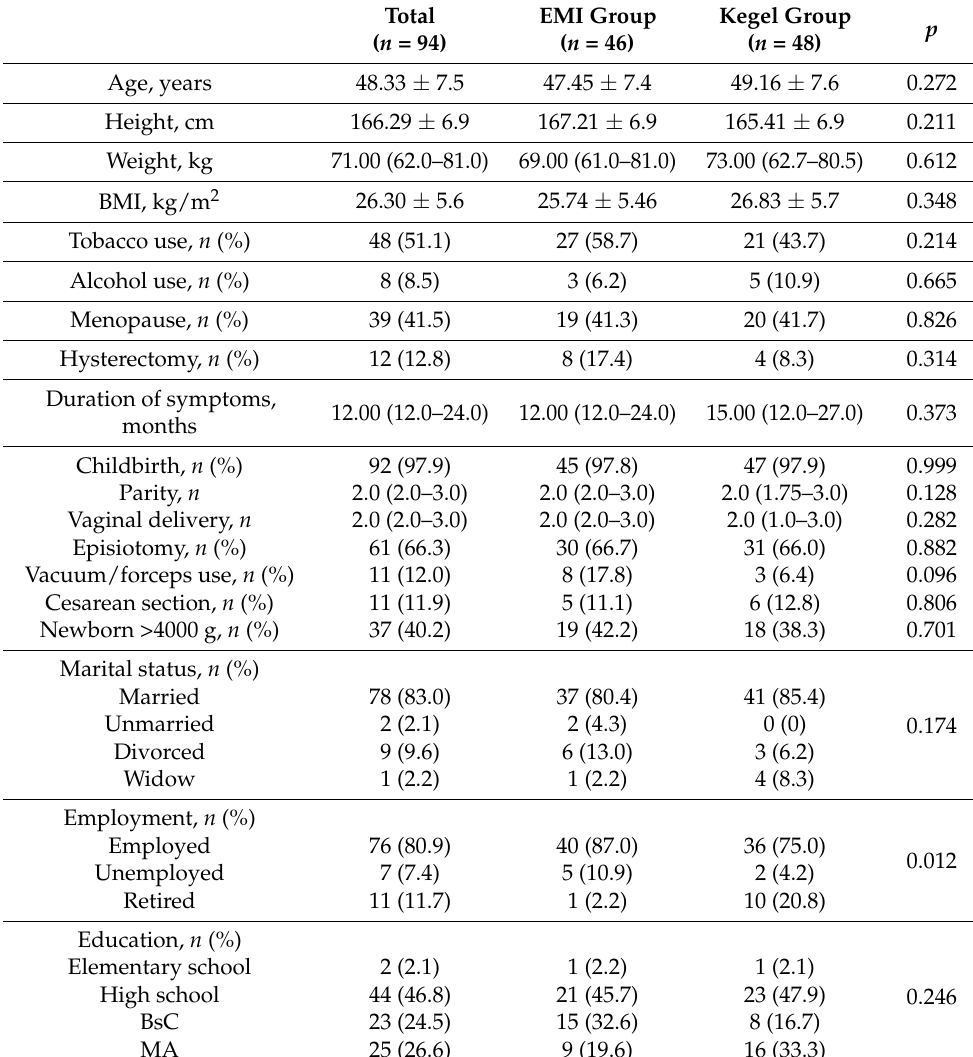
Table 2. Anthropometric and demographic data of the study population.